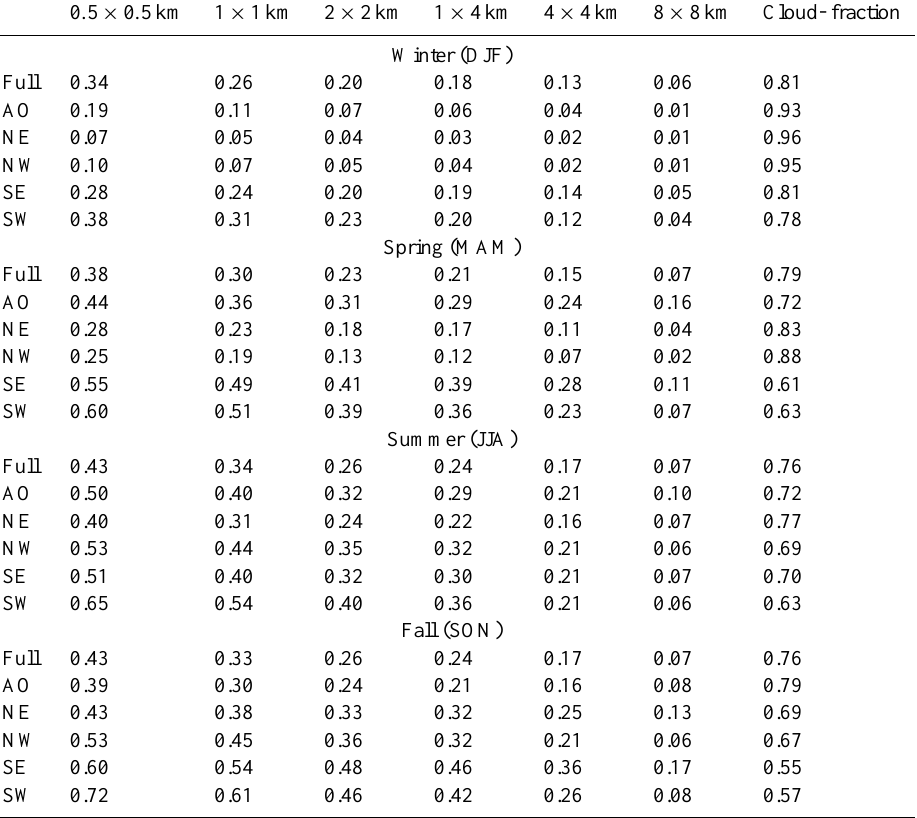
Table 3. Calculated availabilities using MODIS aerosol cloud mask with MODIS input radiances for five spatial resolutions, four seasons, and six domains including the full domain described in Sect. 5.1. Also shown are cloud fractions based on 0 . 5 × 0 . 5km resolution cloud mask for each domain and